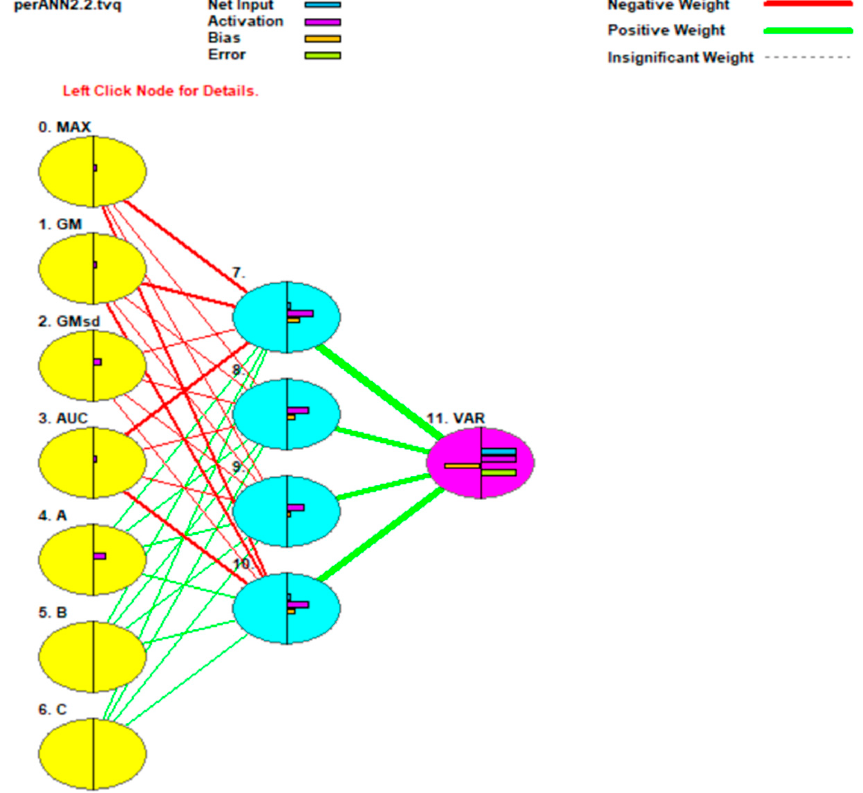
Figure 6. Graphic visualization of the neural network in ANN.